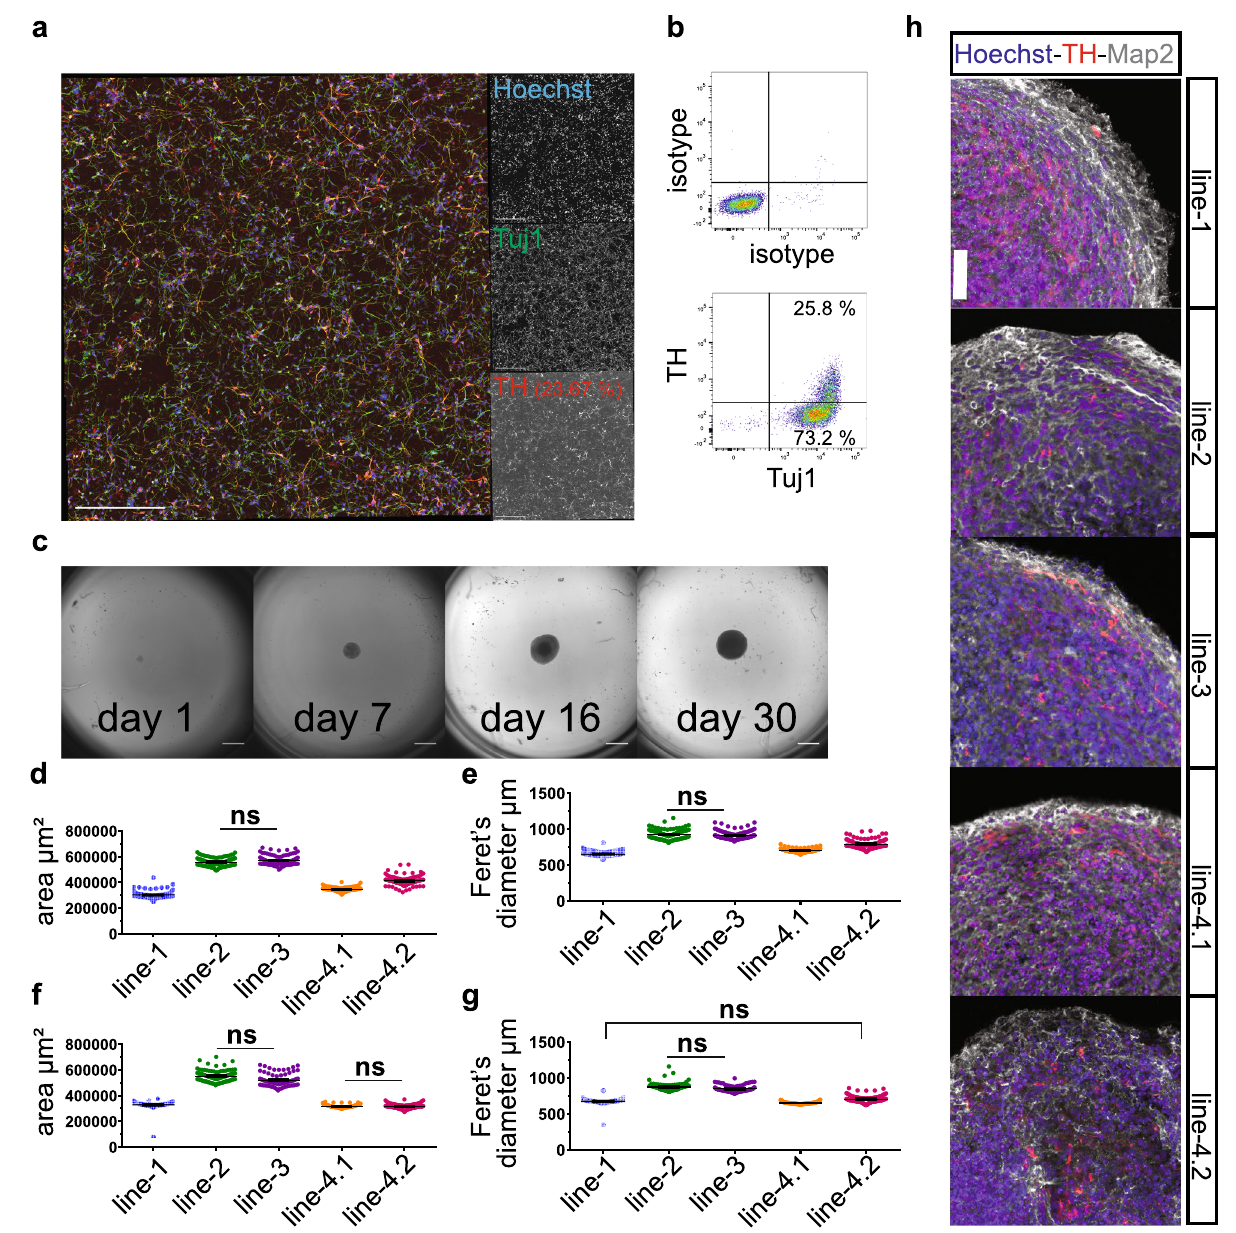
Figure 5. Automated neural differentiation in 2D and 3D. ( a ) Representative image of neurons produced with an automated 2D differentiation protocol for midbrain dopaminergic neurons. Cells were stained with HOECHST (blue, nuclei), anti-Tuj1 antibodies (green, pan-neuronal marker), and anti-tyrosine hydroxylase (TH) antibody (red, dopaminergic neurons). Scale bar = 200 µm. ( b ) Exemplary flowcytometric analysis of Tuj1 and TH expression in neurons from the same differentiation as in ( a ). ( c ) Bright field images of organoids from the same differentiation at indicated days of generation. Scale bar = 500 µm. ( d – g ) Analysis of organoid sizes extracted from brightfield microscopy images. Experiments between which the measured parameter was not significantly different are marked (ns). The observed differences between all other experiments were statistically significant (p < 0.05). ( d ) Organoid area at the end of differentiation (day 30). Five independent differentiations each with 96 organoids are shown. Differentiations were performed at different times. Kruskal–Wallis test followed by Dunn’s multiple comparison test. ( e ) Feret’s diameter of the organoids from ( d ). Kruskal–Wallis test followed by Dunn´s multiple comparison test. ( f ) Organoid area at the end of differentiation from a replication experiment. Differentiations were performed simultaneously. Kruskal–Wallis test followed by Dunn’s multiple comparison test. ( g ) Feret’s diameter of the organoids from (f). Kruskal–Wallis test followed by Dunn’s multiple comparison test. ( h ) Representative immunofluorescence images (maximum intensity projection) of organoids from ( d ) stained with HOECHST (blue, nuclei), anti-Map2 antibodies (white, pan-neuronal marker), and anti- tyrosine hydroxylase (TH) antibody (red, dopaminergic neurons). Scale bar = 50